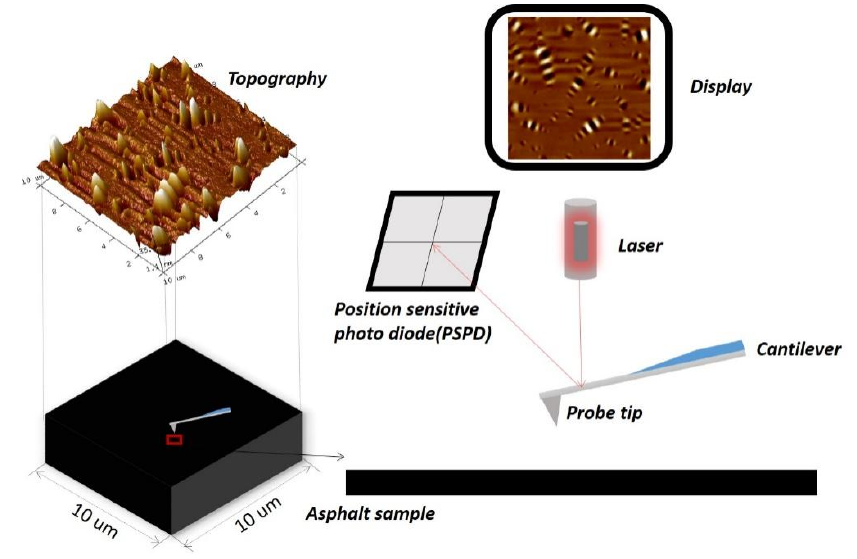
Figure 1. Schematic diagram of AFM.